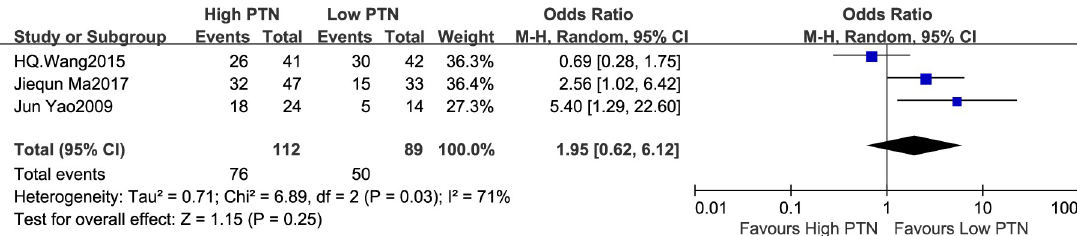
Fig 3. A forest plot for the association between the PTN expression levels with LNM. The LNM was not remarkably increased in the high PTN expression group compared with the low PTN expression group.